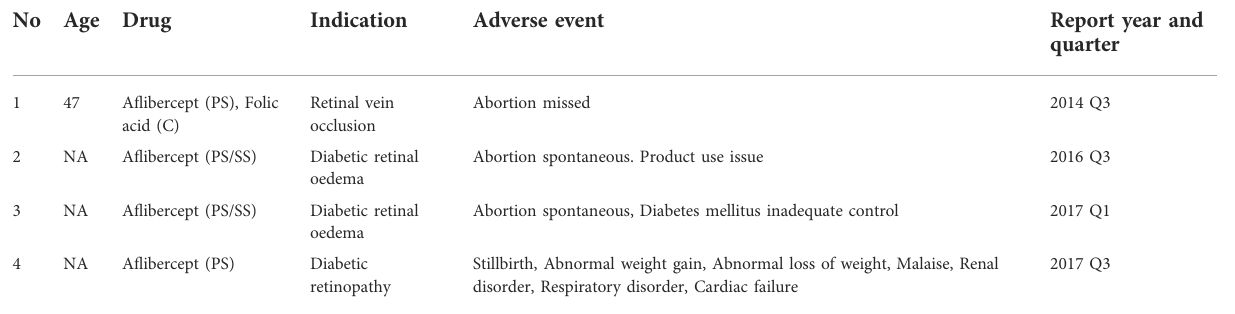
Diabetic Stillbirth, Abnormal weight gain, Abnormal loss of weight, Malaise, Renal retinopathy disorder, Respiratory disorder, Cardiac